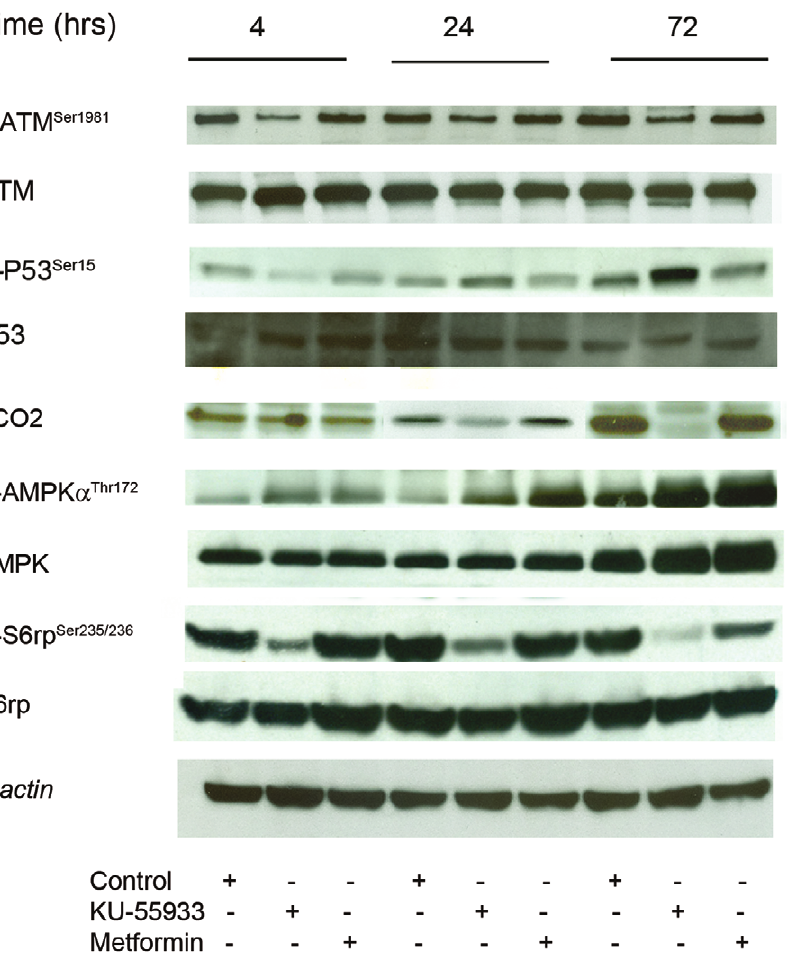
Figure 3. Inhibition of ATM by KU-55933 decreases SCO2 expression in MCF-7 cells. MCF-7 cells were exposed to KU-55933 (10 m M) for the indicated time. After harvesting, cells were lysed and prepared for immunoblot analyses using antibodies against SCO2, phospho-ATM (Ser 1981 ), ATM, phosphorylated p53 (Ser 15 ), p53, phospho-S6 (Ser 235/236 ), S6rp, phospho-AMPK (Thr 172 ) and AMPK. ß-actin is shown as a loading control. The results are representative of three individual experiments.